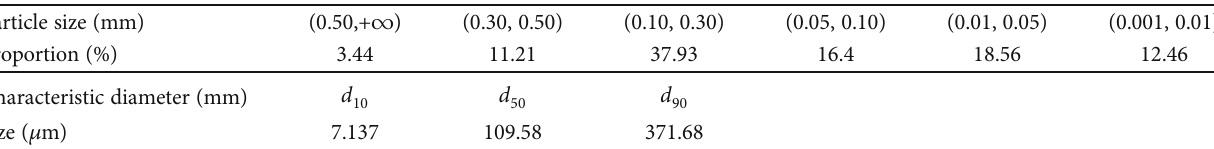
Figure 3: The particle size distributions of full tailings of LLGM (curve 1 is cumulative; curve 2 is incremental). Table 1: Particle size characteristics of unclassi fi ed